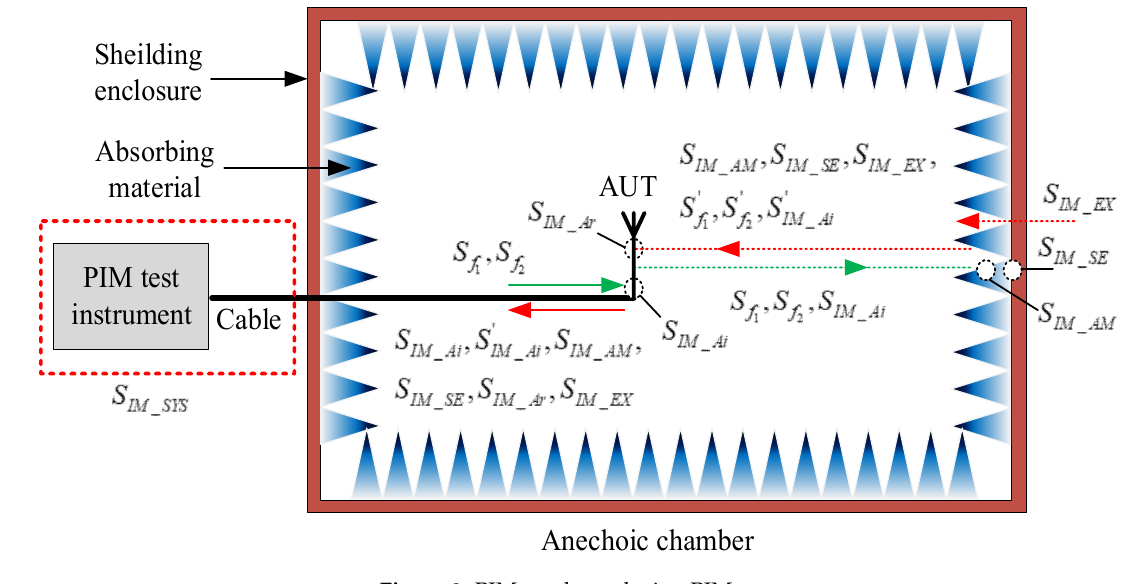
Figure 2. PIM products during PIM test.